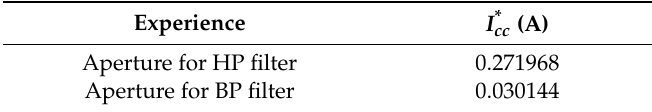
Table 8. Average values of the short-circuit current under STC for the experiments performed with the aperture for filters used.